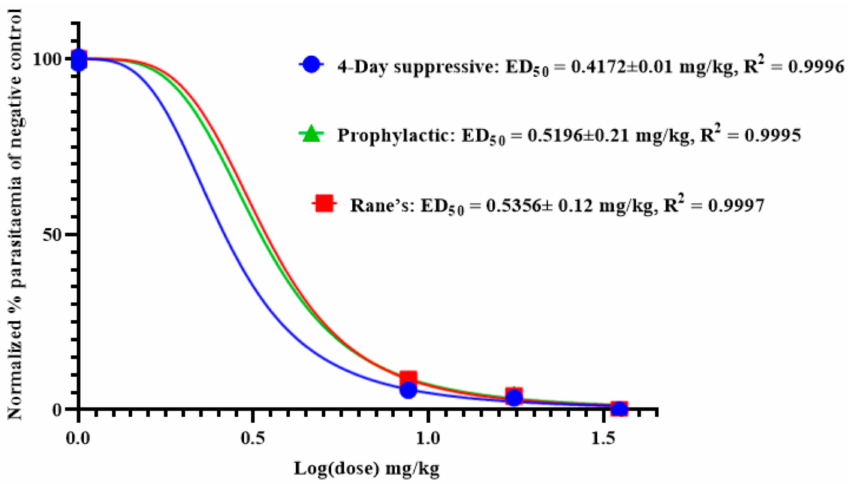
Figure 3. ED 50 of anemonin in mice infected with Plasmodium berghei in 4-day suppressive, Rane’s, and prophylactic antimalarial tests; ED 50 was estimated from a plot of log dose against the percentage of parasitemia of negative control group (normalized); values are presented as mean ± SEM; n =